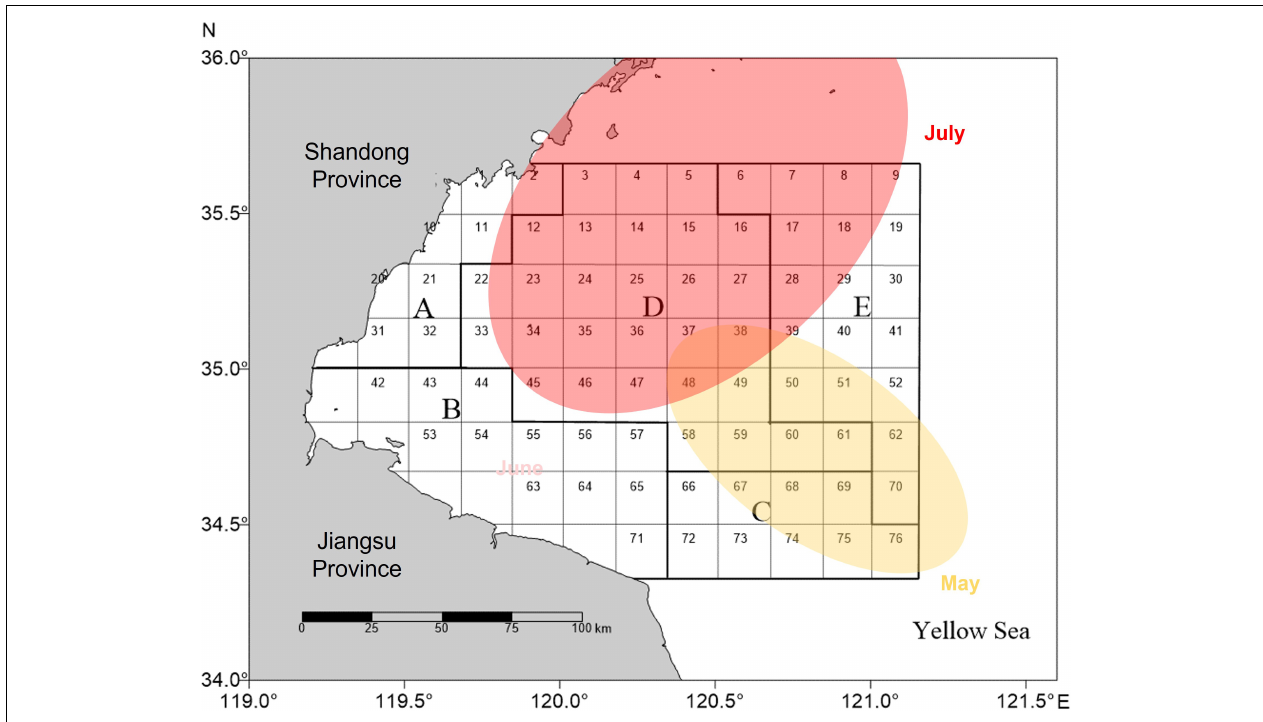
FIGURE 1 | The southern part of the Yellow Sea offshore Jiangsu and Shandong provinces as study region. A fishery is simulated based on the random-stratified survey data from the illustrated region (Xu et al., 2015). Approximate monthly distribution of the green tides is shown in different